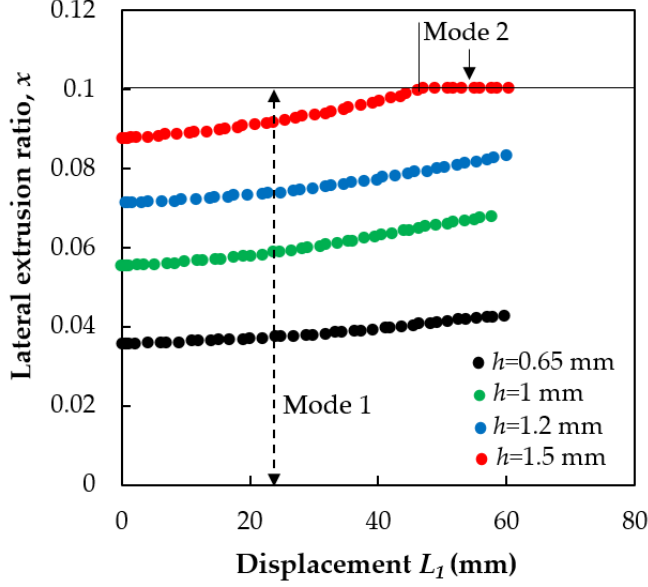
Figure 5. The lateral extrusion ratio x as the function of the displacement L 1 of the back ‐ pressure punch for four values of the gap ‐ width h .